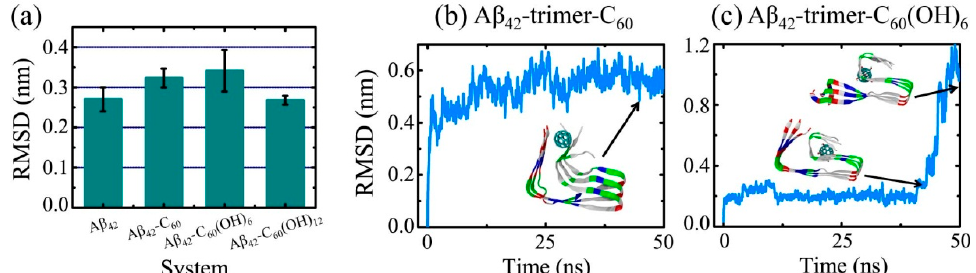
Figure 4. Influence of fullerene/fullerenol molecules on the A β 42 -trimer structure. ( a ) The average C α -root-mean-square deviation (C α -RMSD) relative to the initial coordinates of A β 42 protofibrillar trimer. The values for A β -fullerene/fullerenol systems were calculated over all six MD runs for each simulated system using the last 20 ns data of each MD trajectory, and those for isolated A β 42 -trimer systems were averaged over the last 50 ns data of two independent 200-ns MD runs. ( b , c ) Time evolution of C α -RMSD of the MD trajectory that contributes most to the total C α -RMSD in A β 42 -trimer-C 60 and A β 42 -trimer-C 60 (OH) 6 systems, respectively. The color code of the inset snapshots is consistent with that in Figure